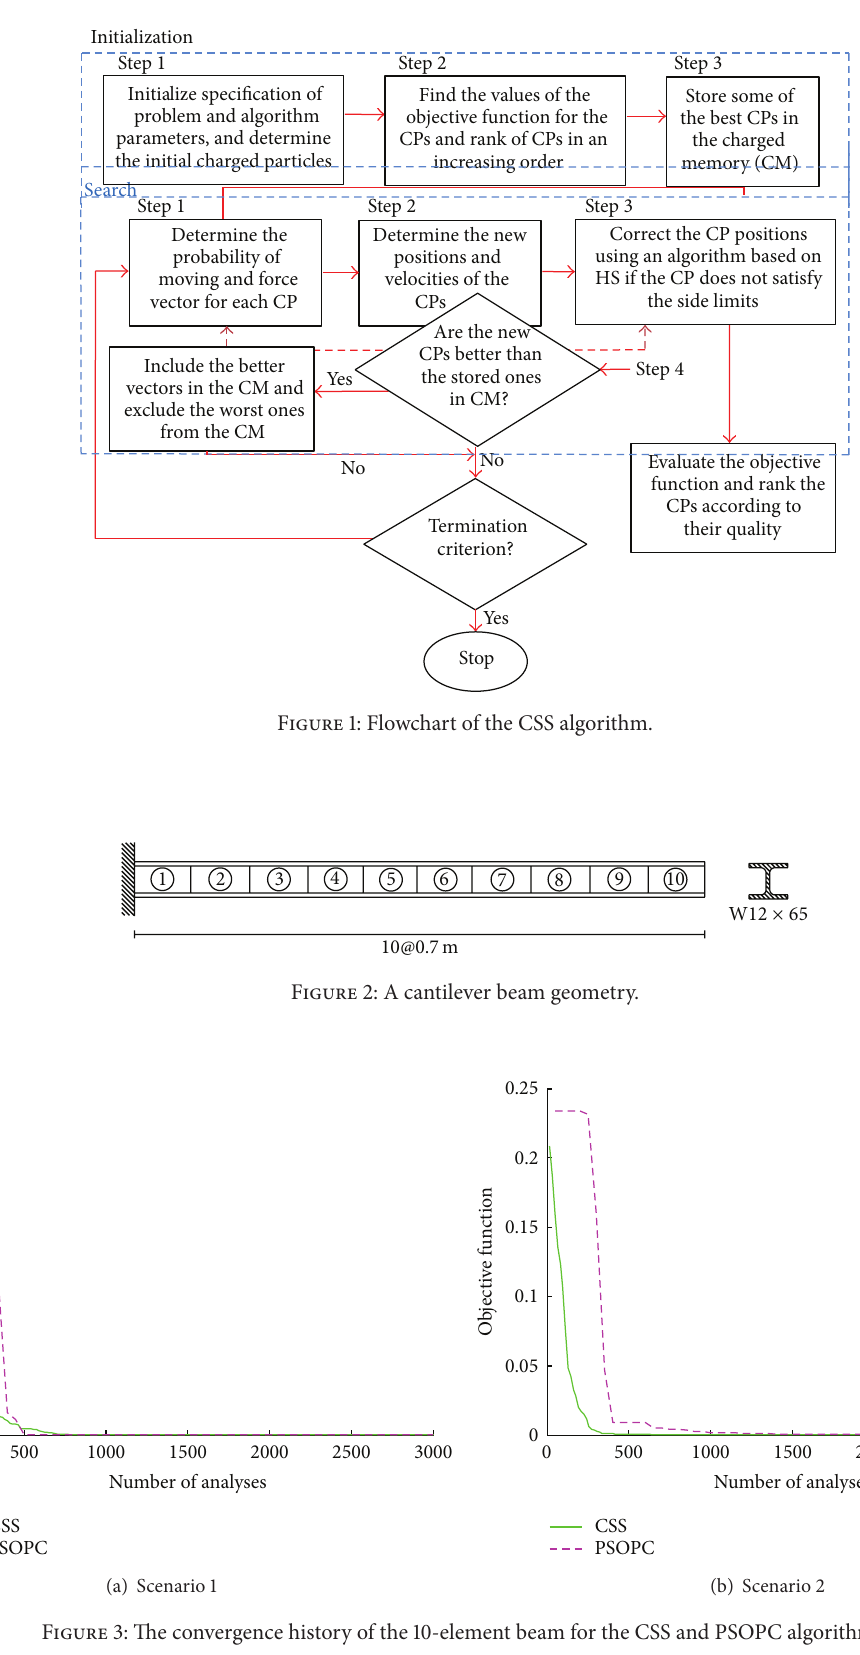
Figure 3: The convergence history of the 10-element beam for the CSS and PSOPC